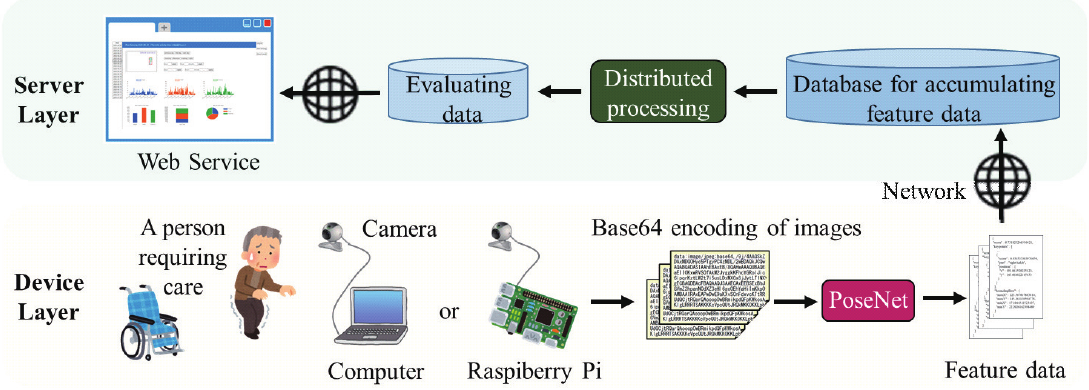
Figure 5. Flowchart of the proposed